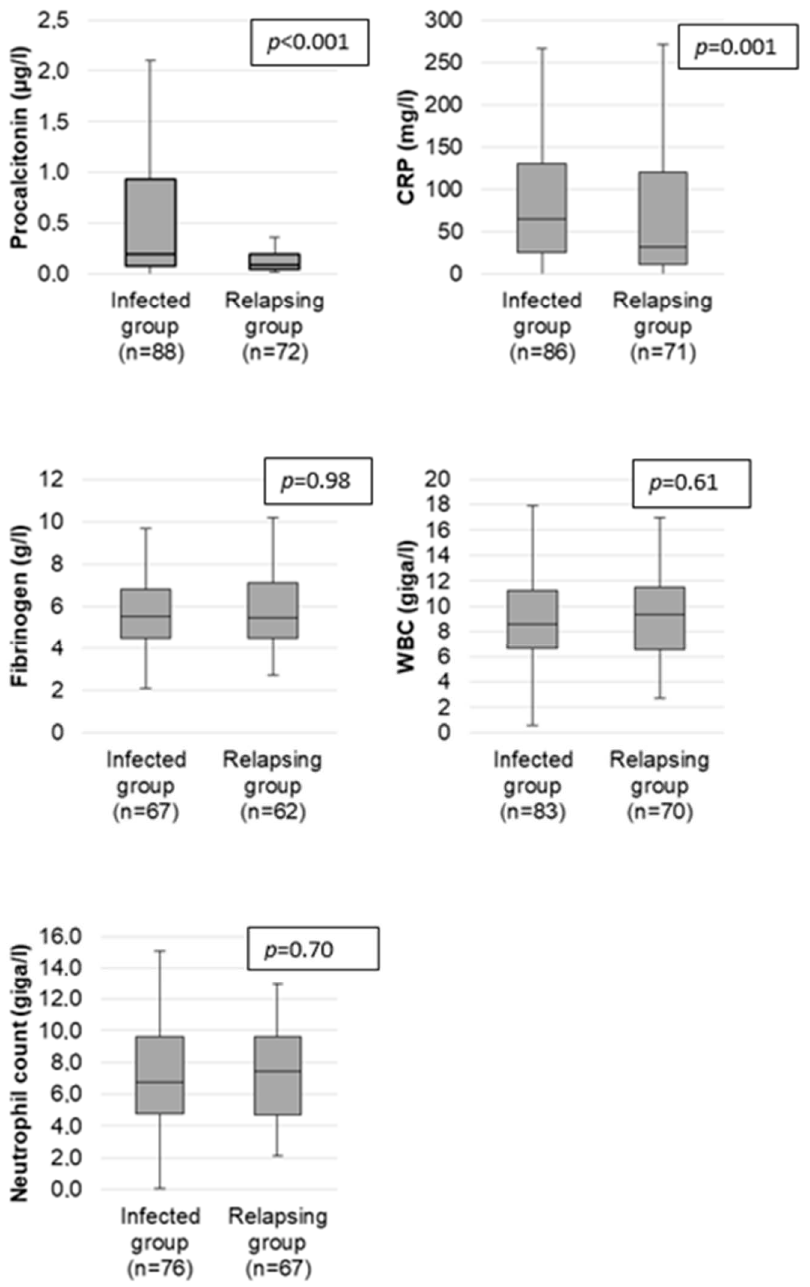
Figure 1. Comparison of PCT, CRP, fibrinogen, leukocytes, and neutrophil levels at relapse and at infection in the population of 74 patients with AAV.